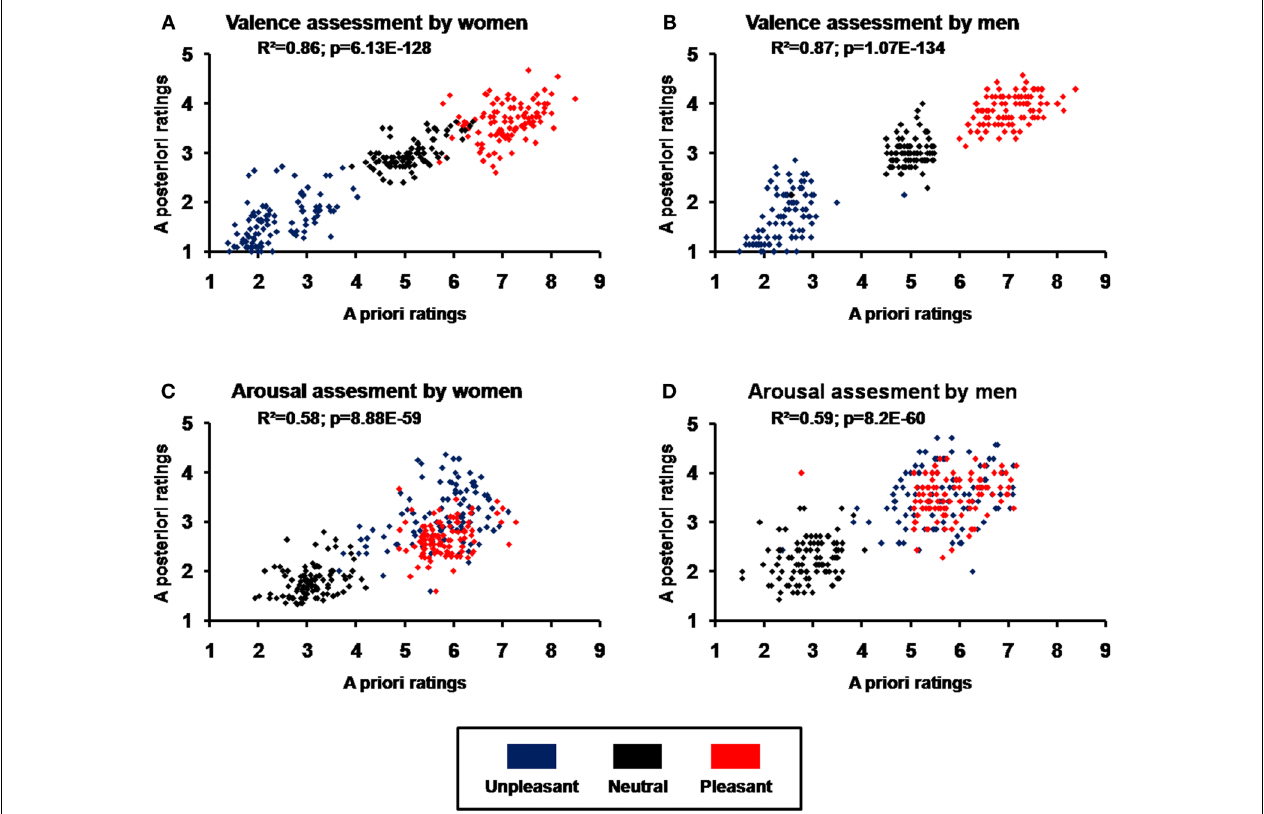
FIGURE 2 | Validation of picture selection using correlations between standardized (a priori) ratings by the International Affective Picture System (IAPS) and mean subjective (a posteriori) ratings of unpleasant, neutral, and pleasant images. (A) Valence ratings for women; (B) valence ratings for men; (C) arousal ratings for women; (D) arousal ratings for